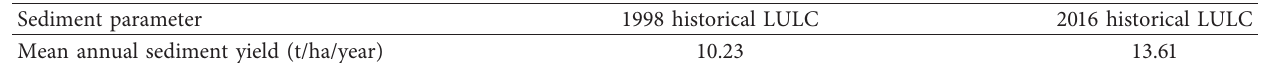
Table 16: Change in sediment yield due to land use